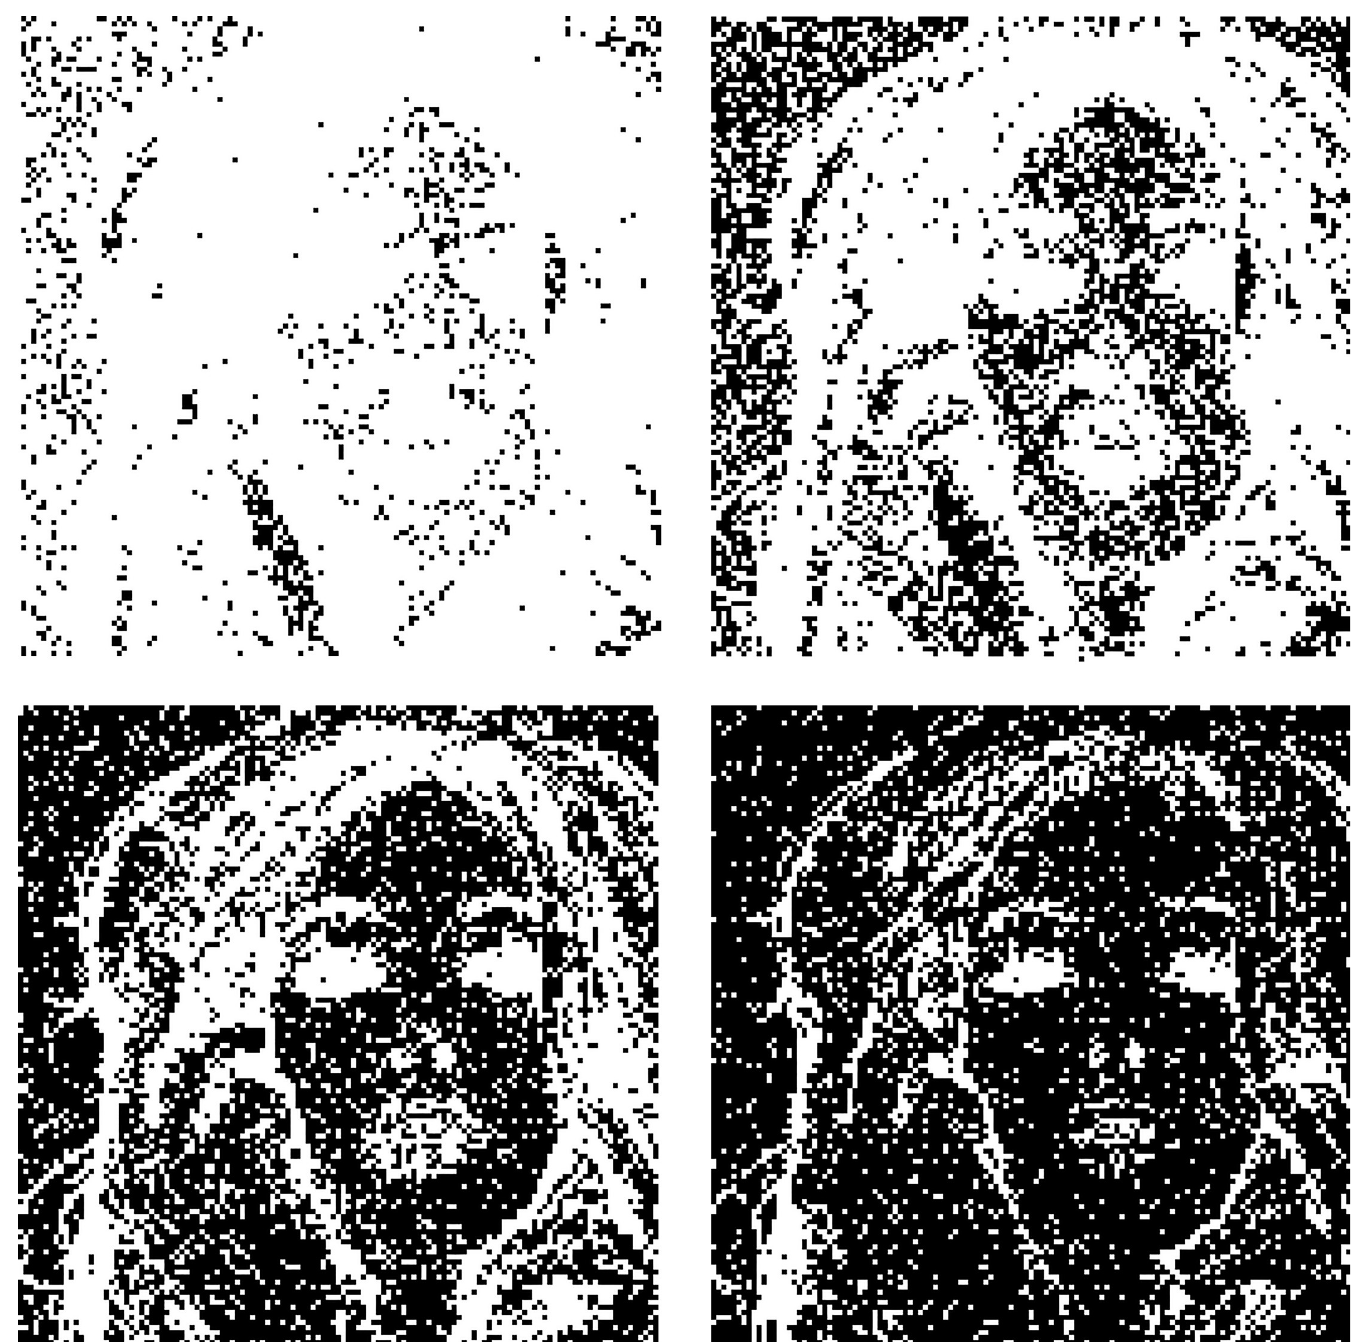
Fig 7. Effect of using the bit toggling technique. (a) λ = 4. (b) λ = 16. (c) λ = 64. (d) λ = 256.